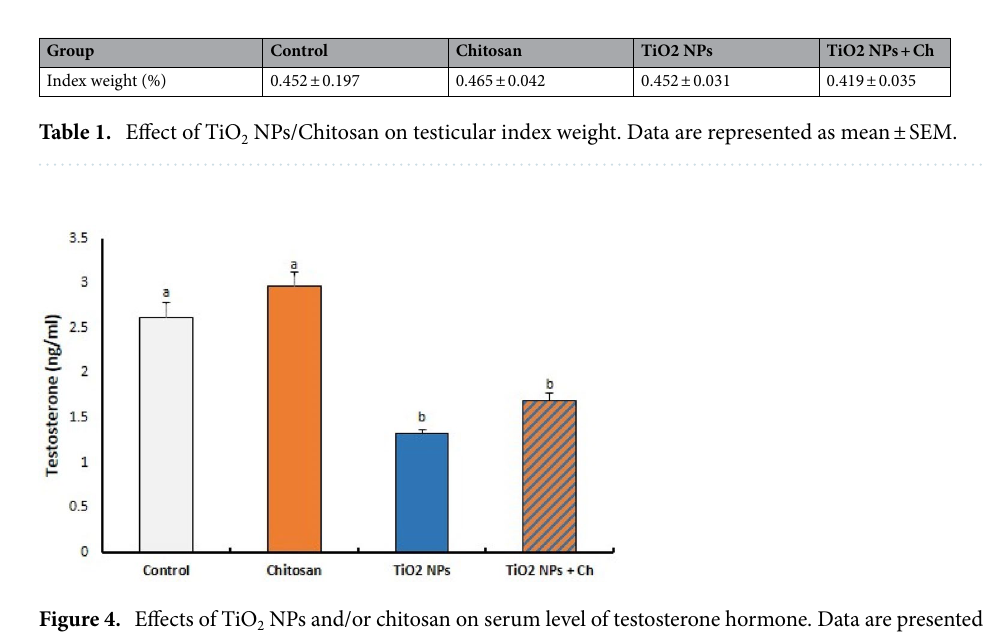
Figure 4. Effects of TiO 2 NPs and/or chitosan on serum level of testosterone hormone. Data are presented as means ±